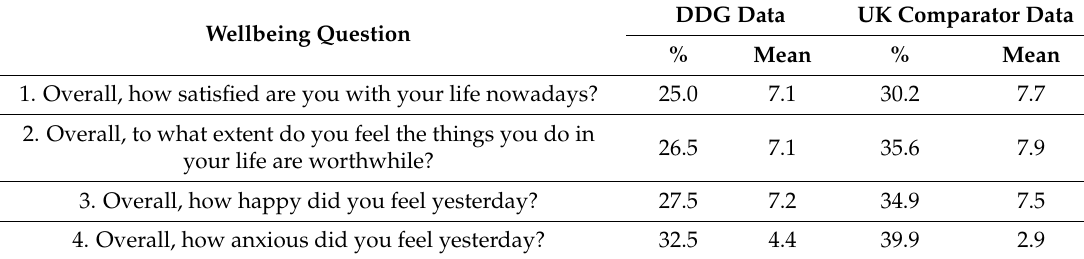
Table 1. General wellbeing scores for intervention participants and the UK population. Percentages for items 1, 2 and 3 refer to respondents who scored 9 or 10 on a scale from 0 (not at all) to 10 (completely). Percentages for item 4 refer to respondents who scored 1 or 2 on the same scale. DDG: Dementia Dwelling